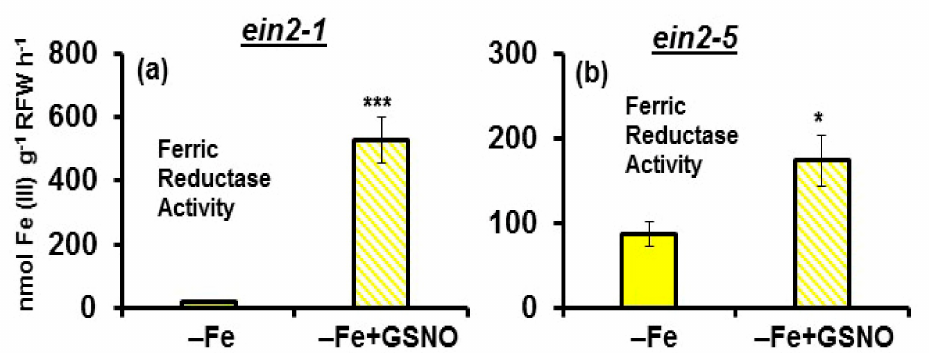
Figure 9. Effect of GSNO (NO donor) on the ferric reductase activity (FRA) of Fe-deficient Arabidopsis ET insensitive ein2-1 ( a ) and ein2-5 ( b ) plants. Plants were grown in complete nutrient solution. When appropriate, they were transferred during 24 h to nutrient solution without Fe (–Fe). GSNO, at 100 µ M final concentration, was added to the nutrient solution of half of the plants. After treatments, FRA was determined. Data represent the mean of 6 replicates ± S.E. Bars with * or *** indicate significant differences ( p < 0.05 or p < 0.001) in relation to the –Fe treatment according to the Student’s test t .